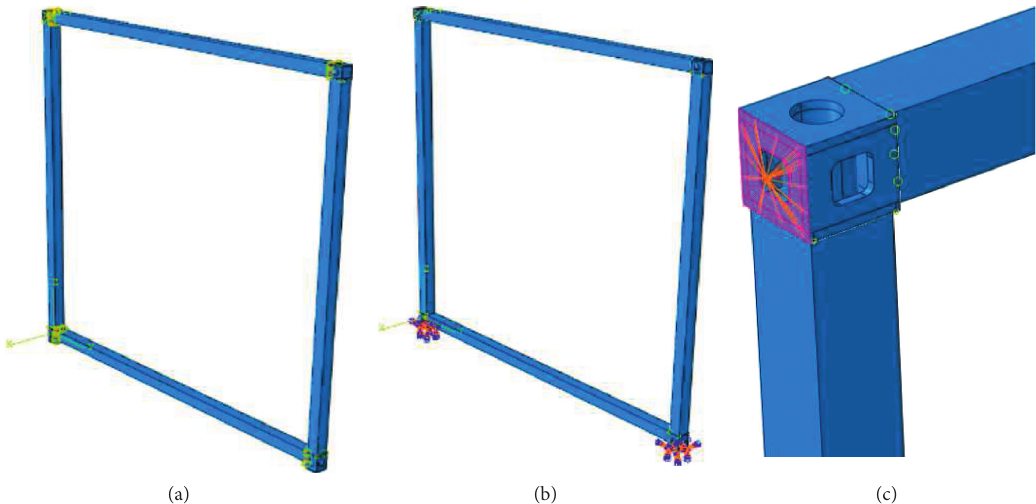
Figure 9: Interaction and loading settings of QKX-1. (a) Beam-column connection. (b) Consolidated corner piece. (c) Point-coupled surface loading.